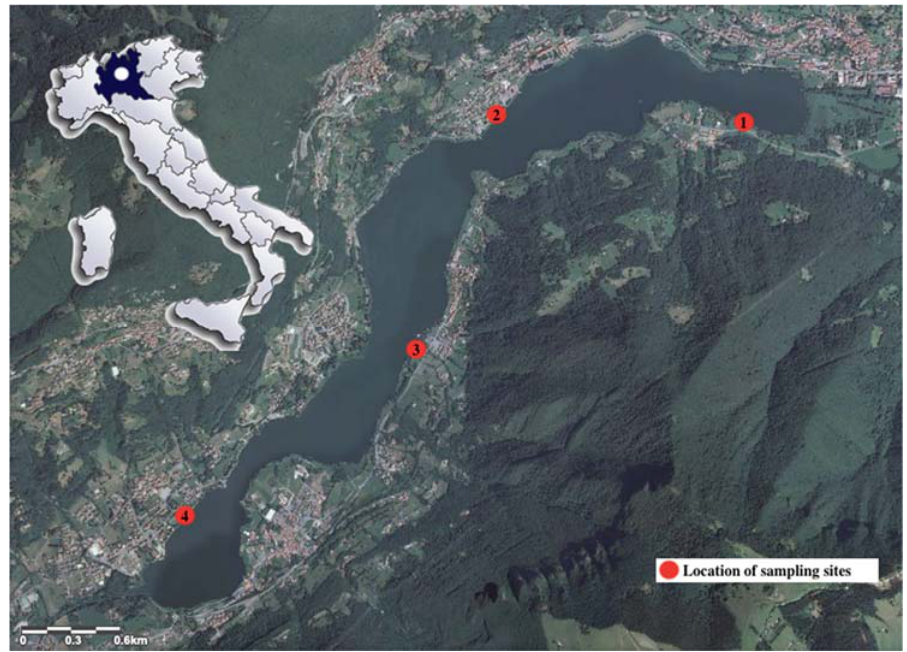
Figure 1. Lake Endine (Lombardy, northern Italy) and location of sampling sites (in red): site 1 (45°47 ʹ 15.3 ʺ N 9°57 ʹ 53.3 ʺ E); site 2 (45°47 ʹ 22.1 ʺ N 9°56 ʹ 58.0 ʺ E); site 3 (45°46 ʹ 25.2 ʺ N 9°56 ʹ 26.5 ʺ E); site 4